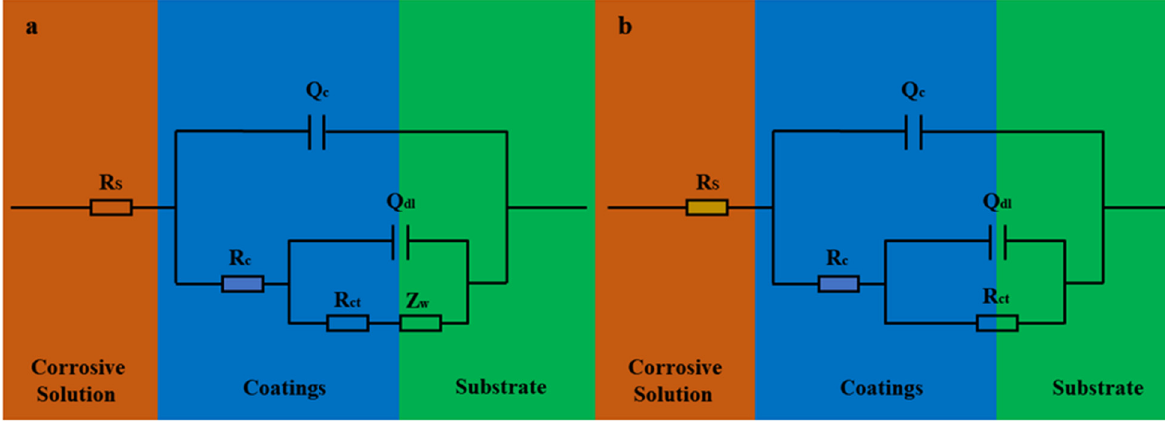
Figure 9: EEC models for composite coatings.